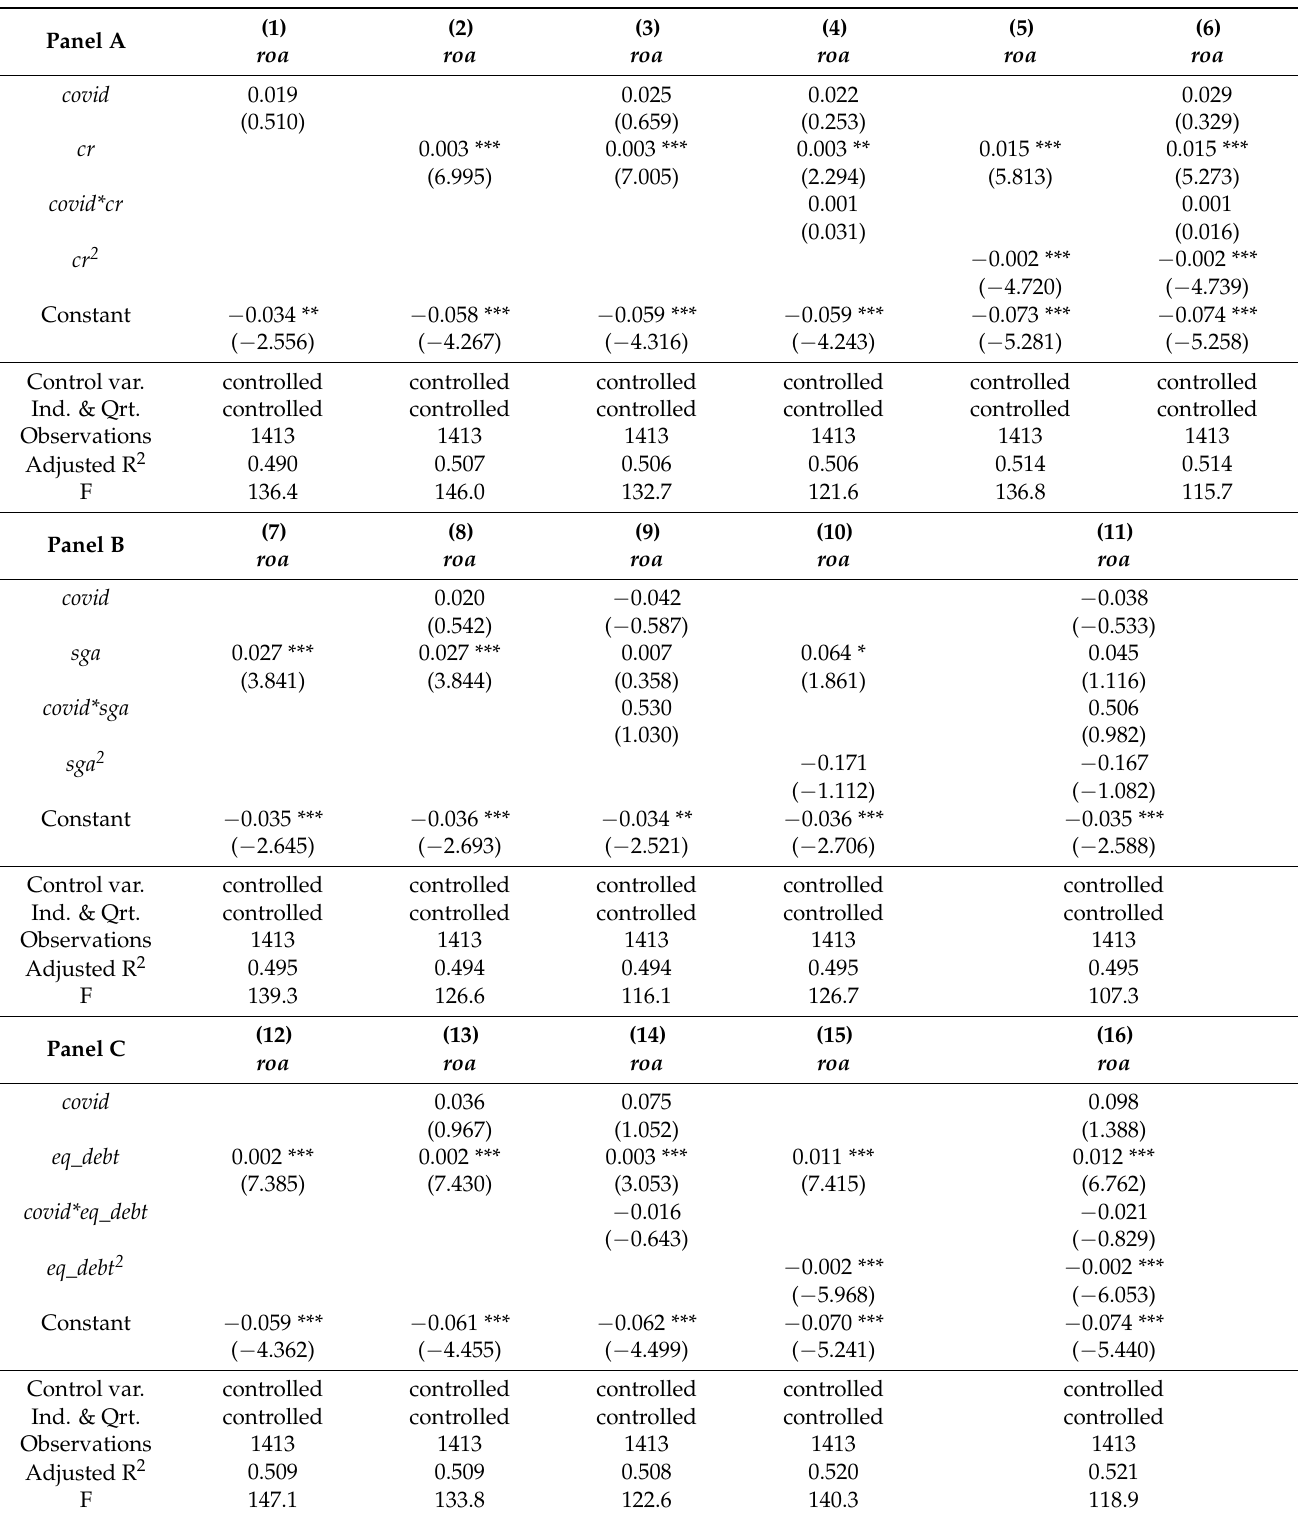
Table 9. Regression Results for H3: Industries not impacted negatively by